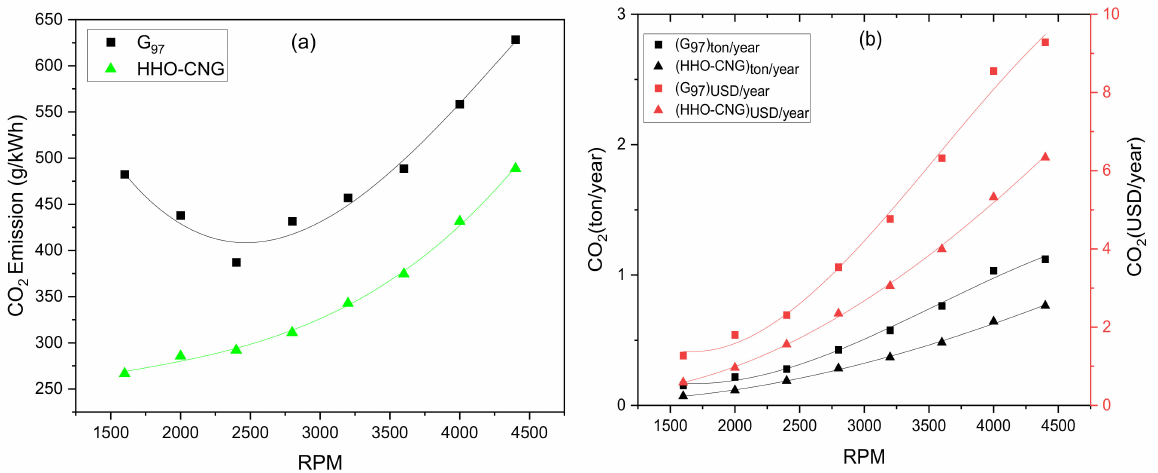
Figure 7. ( a ) CO 2 emission variations with respect to engine speed in terms of percentage by volume and ( b ) CO 2 emission variations in terms of ton/year when associated with cost variation for a year against engine